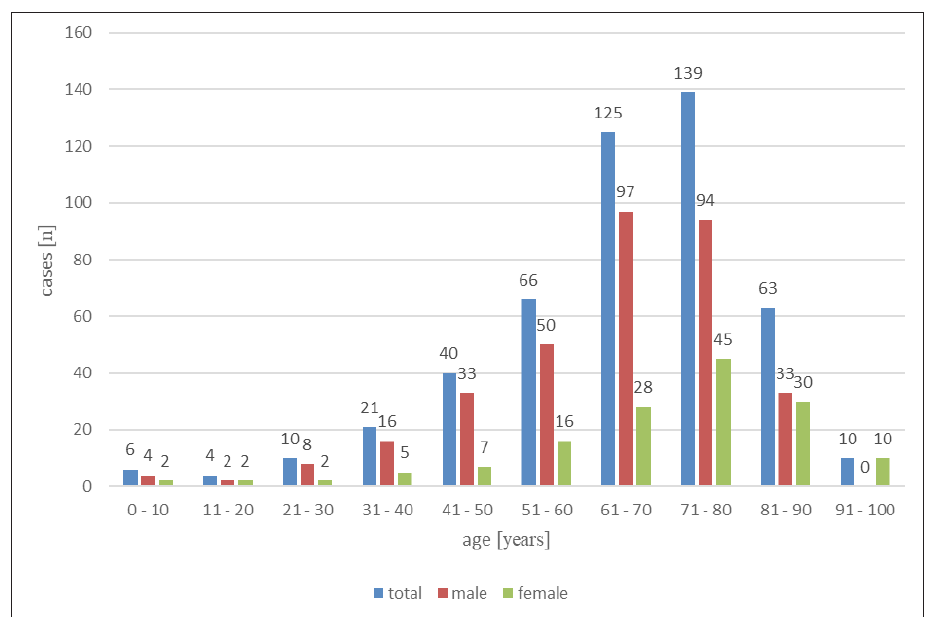
Fig. 2. Number of cardiac arrests according to age group and